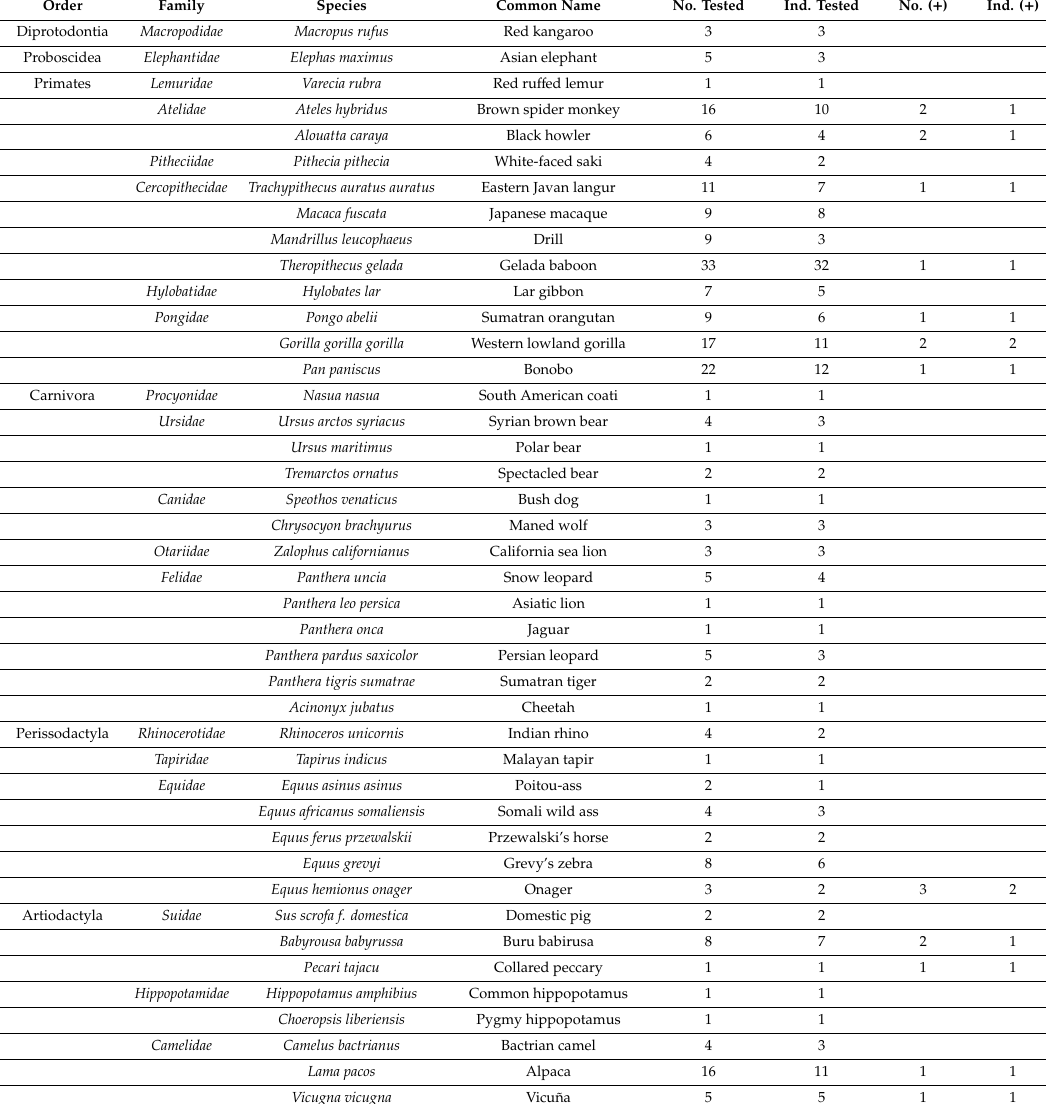
Table 1. Results of screening serum samples from di ff erent mammalian species using Mycobacterium avium complex indirect